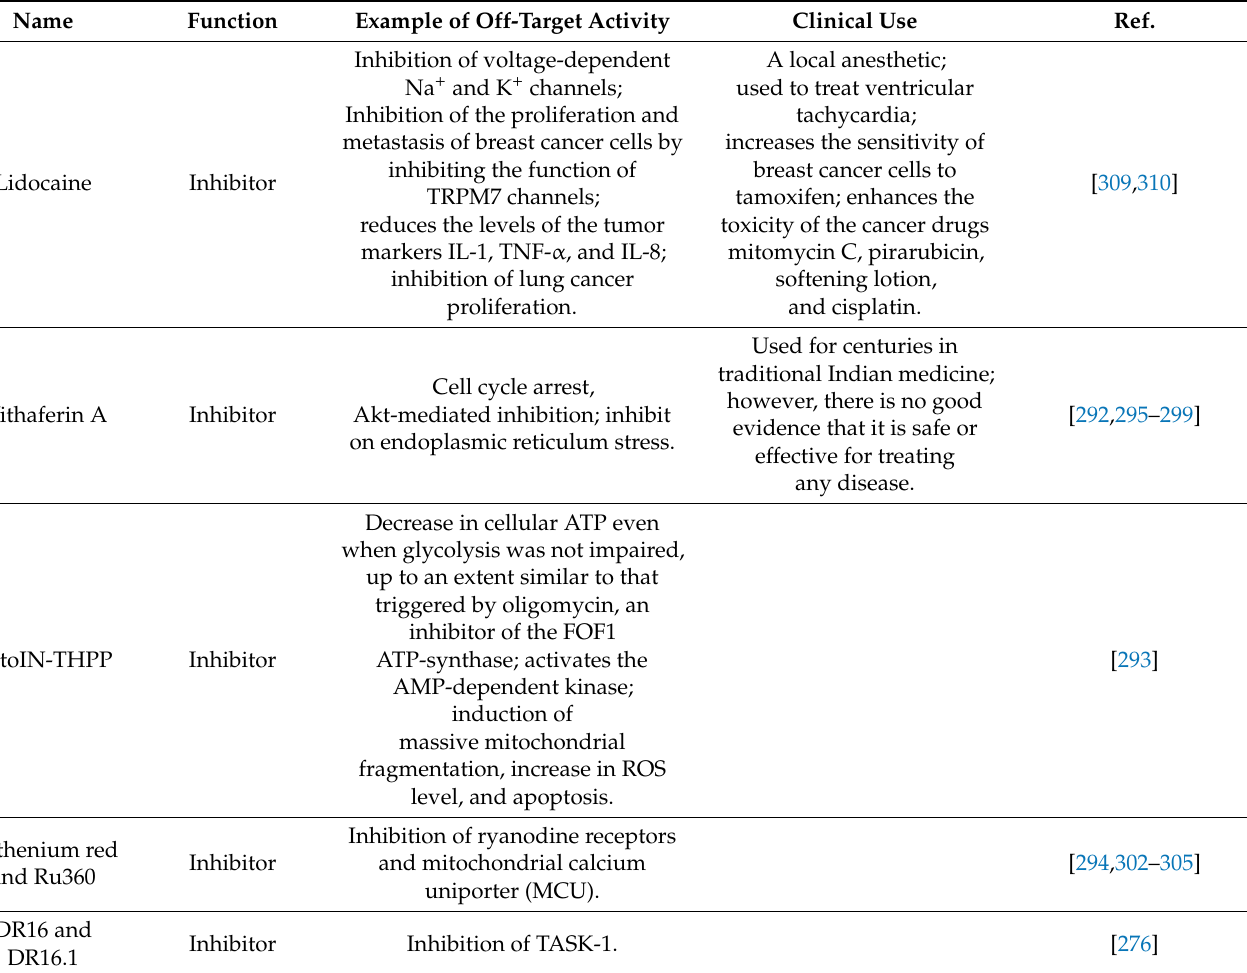
Table 5. Examples of mitochondrial TASK-3 channels modulators and their off-target